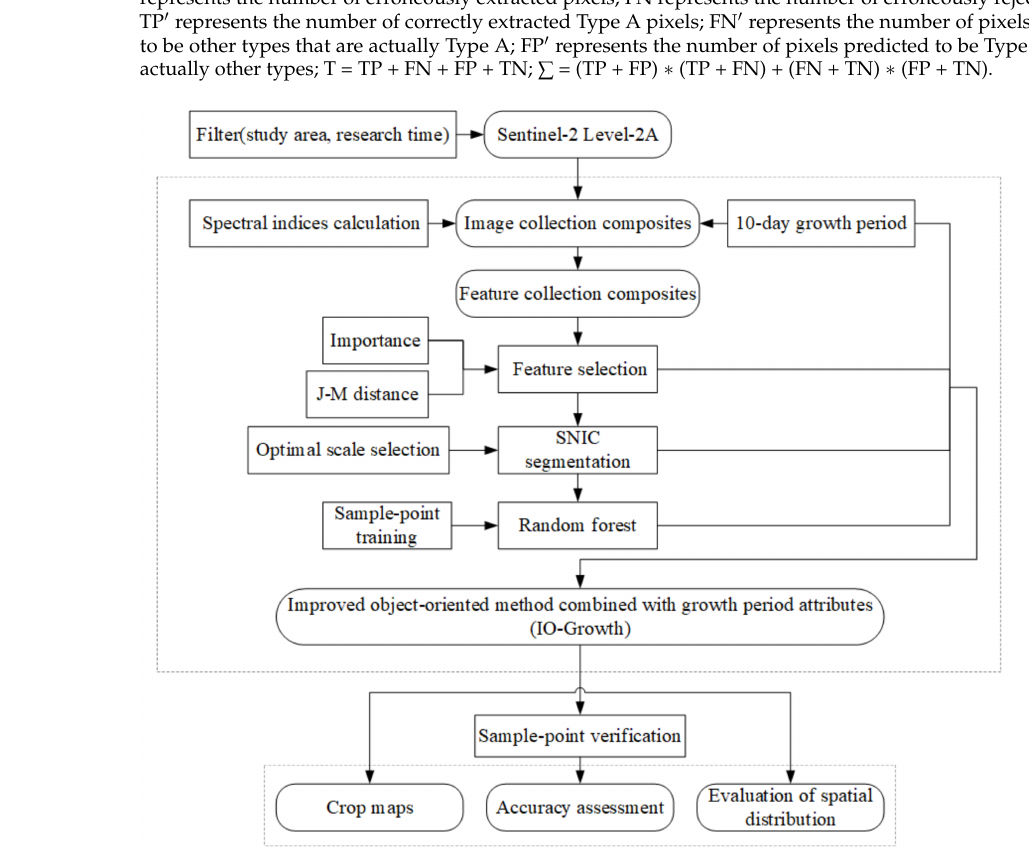
Figure 3. Methodological workflow employed in the current